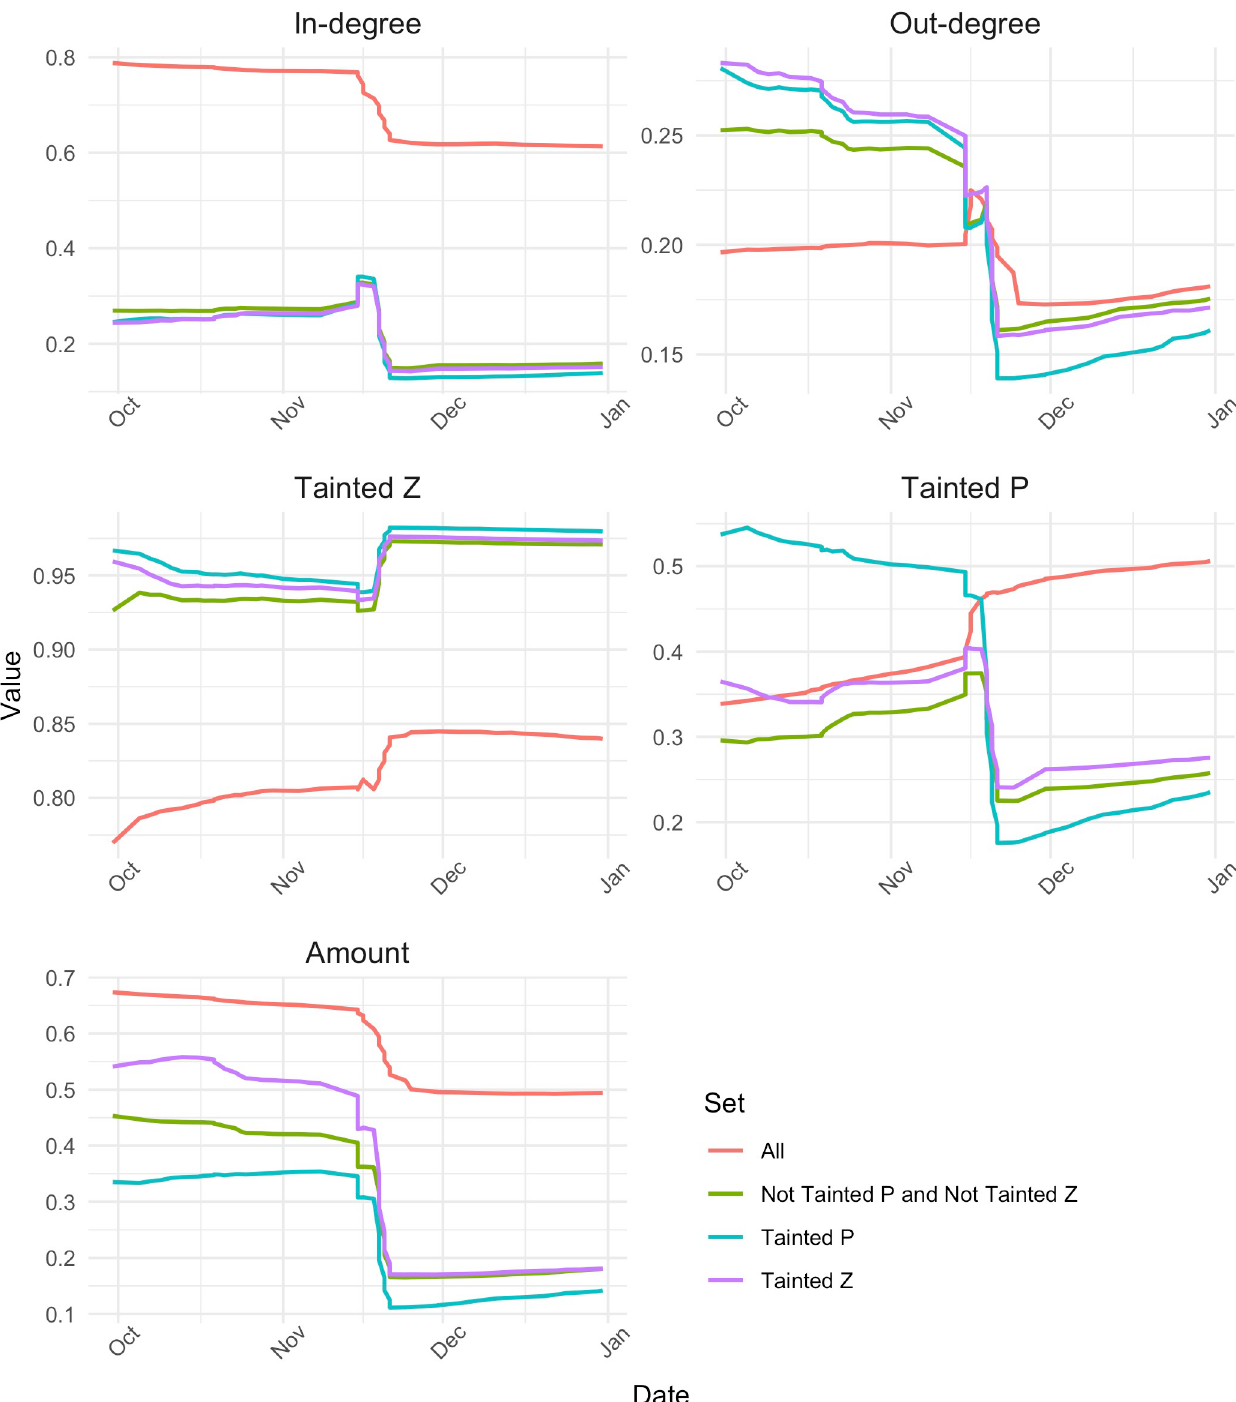
Fig 5. Evolution of Gini coefficients of in-degree, out-degree, tainted Z ratio and tainted P ratio and transaction amount in the full transaction network and three sub-networks in October, November and December 2010.